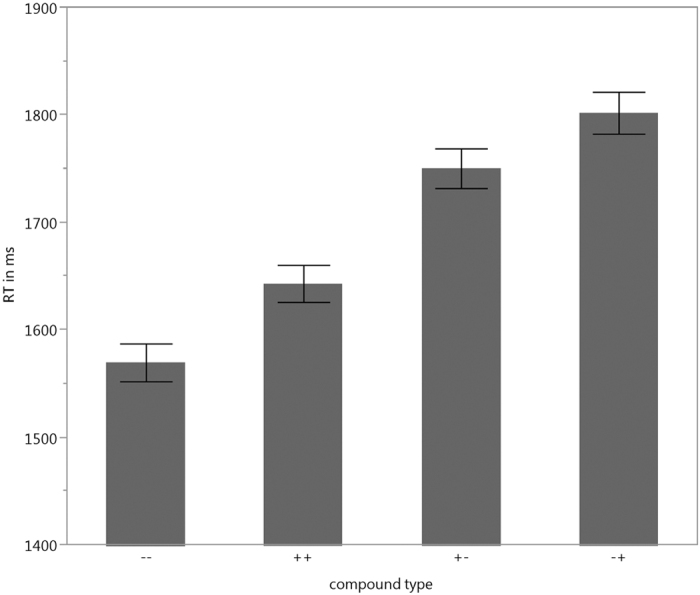
Reaction Times of the VDT (error bars represent standard error).